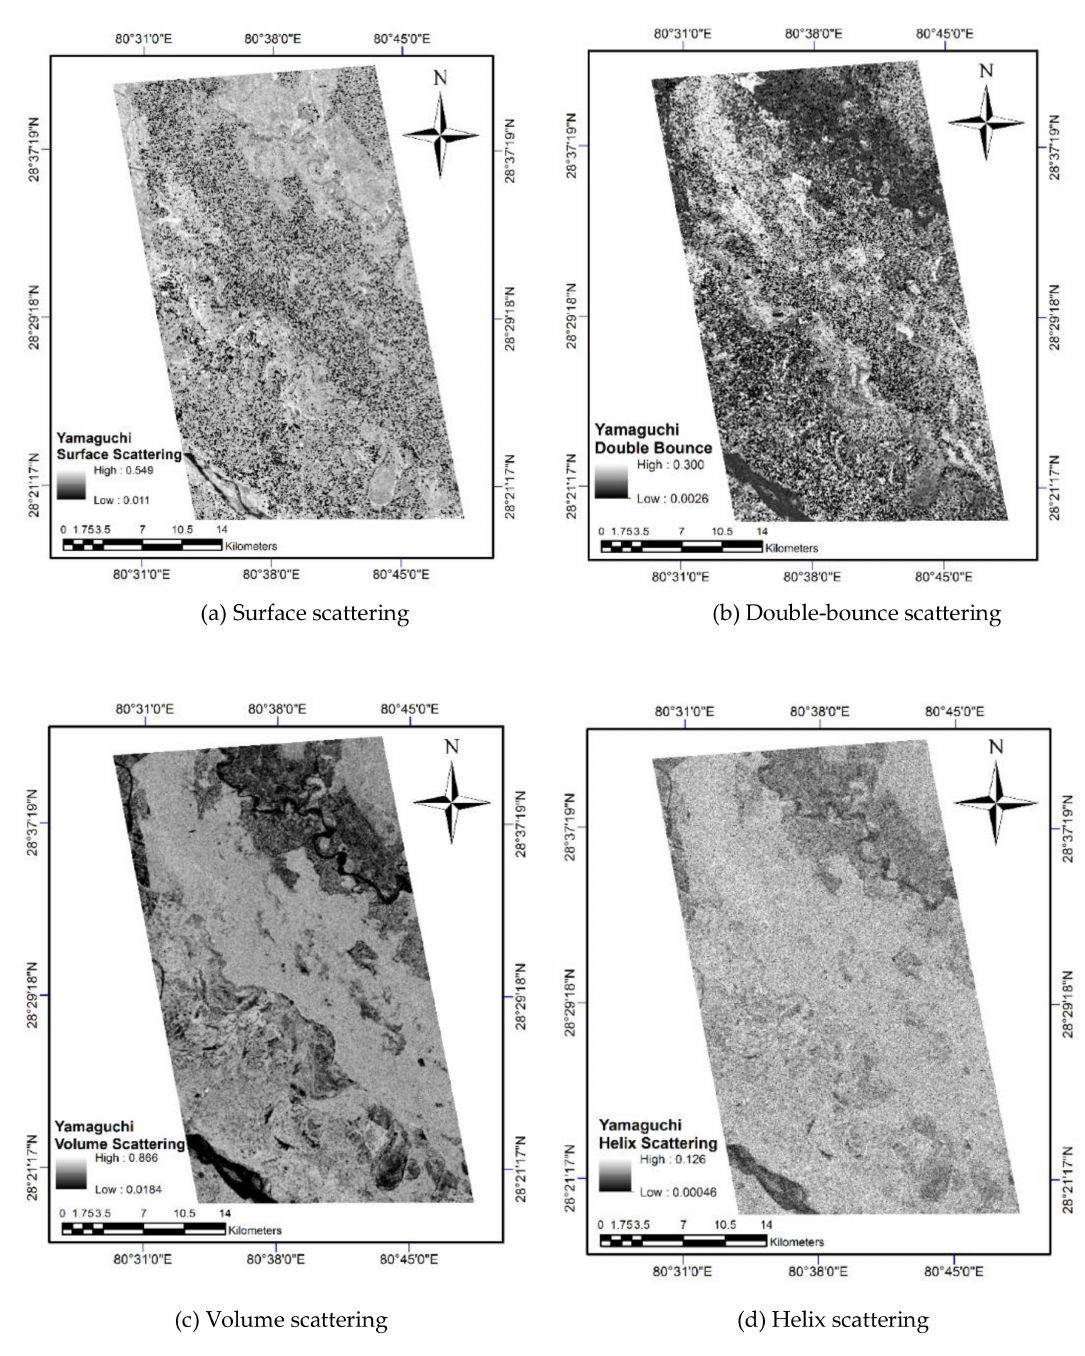
Figure 7. Four-component decomposition of the ALOS PALSAR